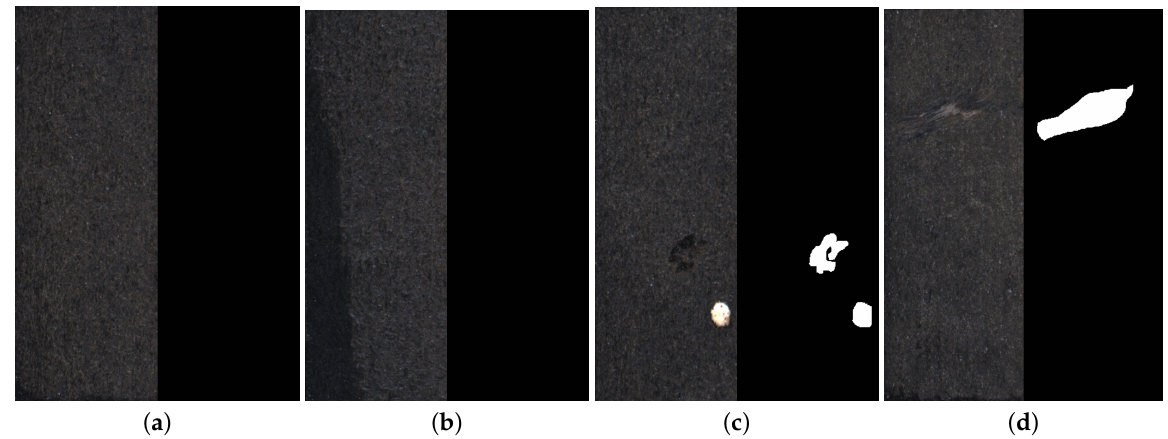
Figure 8. Example images of KolektorSDD2. ( a , b ) are the raw images without defects and its ground truth; ( c , d ) are the raw images with defects and their ground truth.